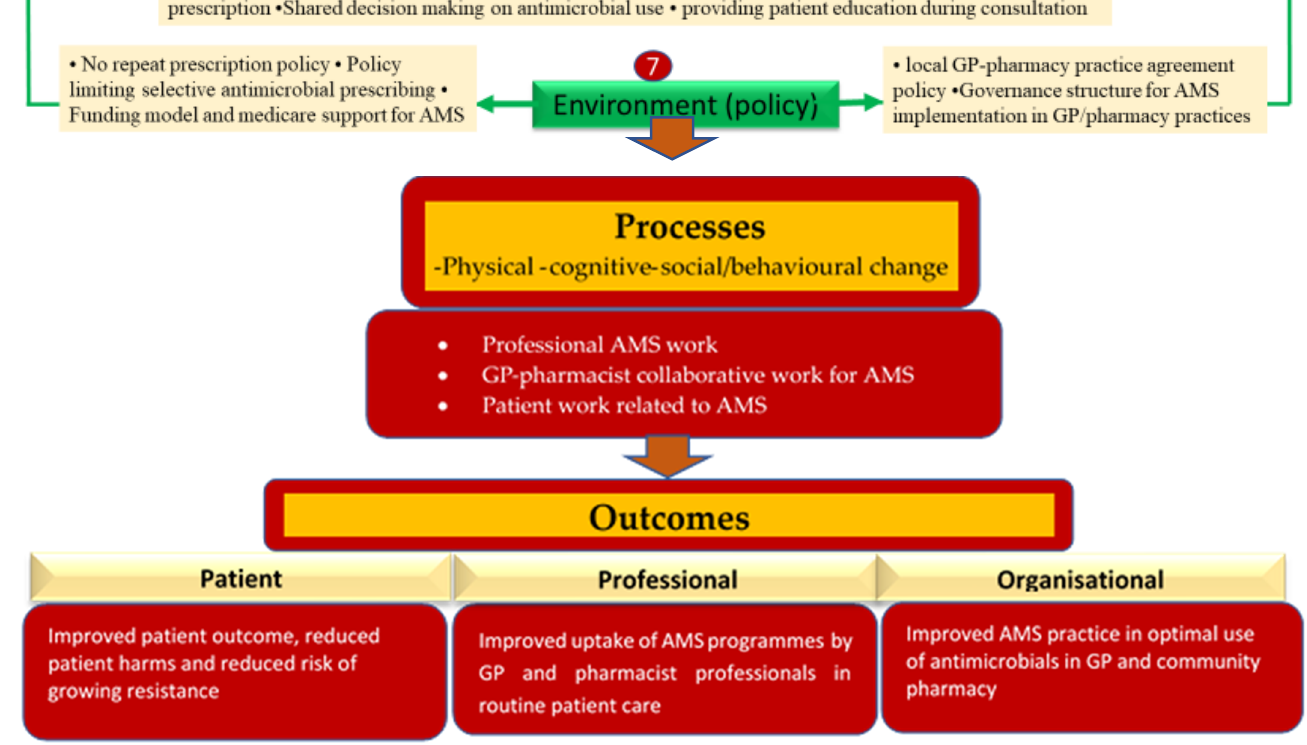
Figure 1. GPPAS implementation model framework guiding AMS implementation by fostered